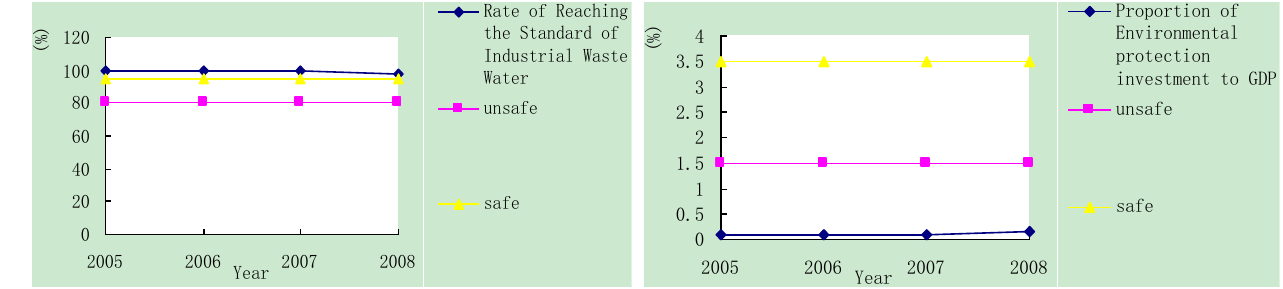
( e ) The key indicators of the response